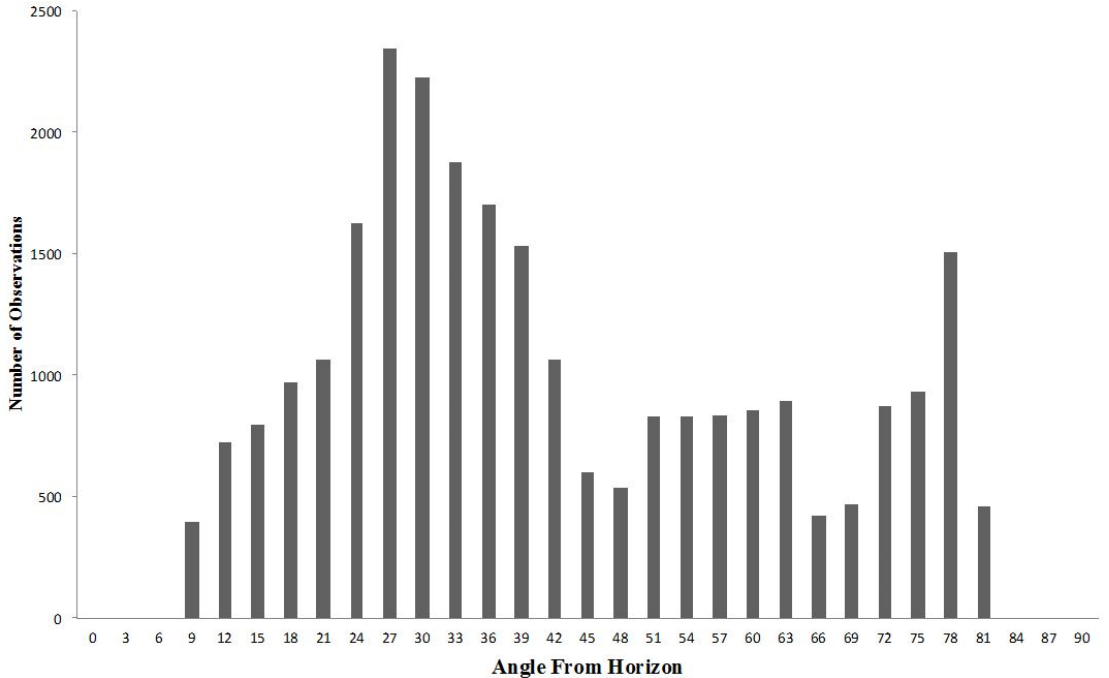
Figure 3. The frequency distribution of GPS observations at different angles from the horizon during the data collection in the spring at West Point, New